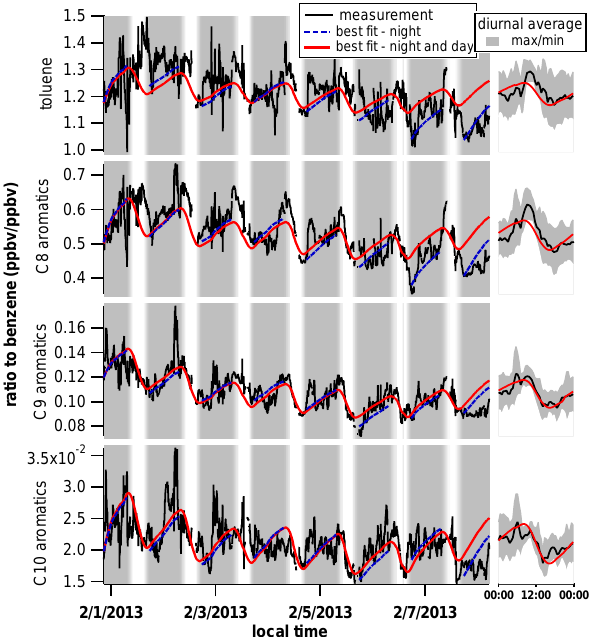
Figure 3. Aromatic compound ratios and best fit to nighttime data (blue) and both night and day data (red). The background is col- ored by sunlight intensity to distinguish day and night. For repro- ducibility, the initial ratio for each night was chosen from the 10th percentile of points during the first 2h of the evening. In practice, best-fit parameters were largely insensitive to the initial ratio, as long as the selected initial ratio was close to measurements during the early part of the night. A diurnal average is shown to the right.